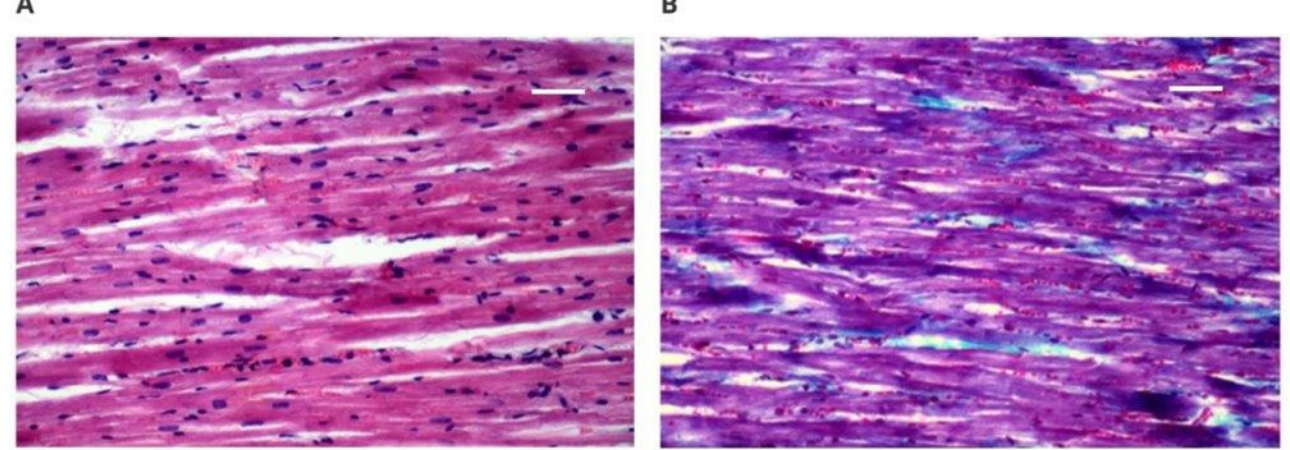
Figure 4. Microscopically assessed image of the liver from the implanted animals: ( A ) 100 × magnification (scale bar 100 µ m), hematoxylin–eosin staining; ( B ) 100 × magnification (scale bar 100 µ m), hematoxylin–eosin staining.